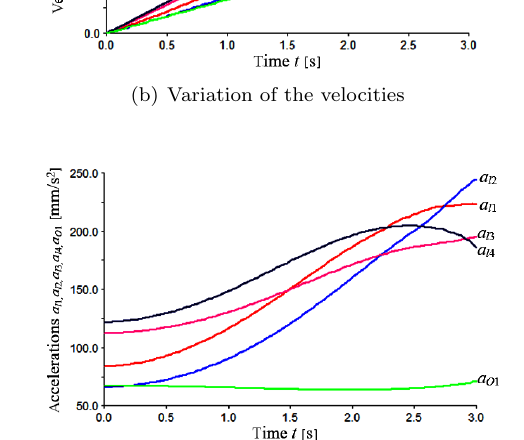
Figure 8: The kinematics and dynamics results of the GHMT obtained fromADAMS